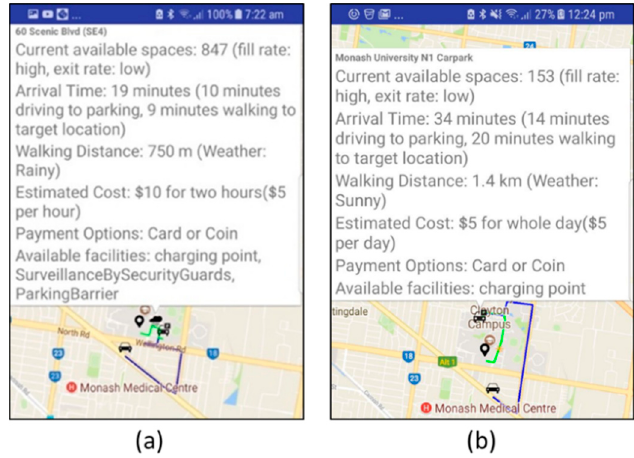
Figure 24. PoC parking application screenshot. ( a ) bad weather conditions; ( b ) good weather conditions.